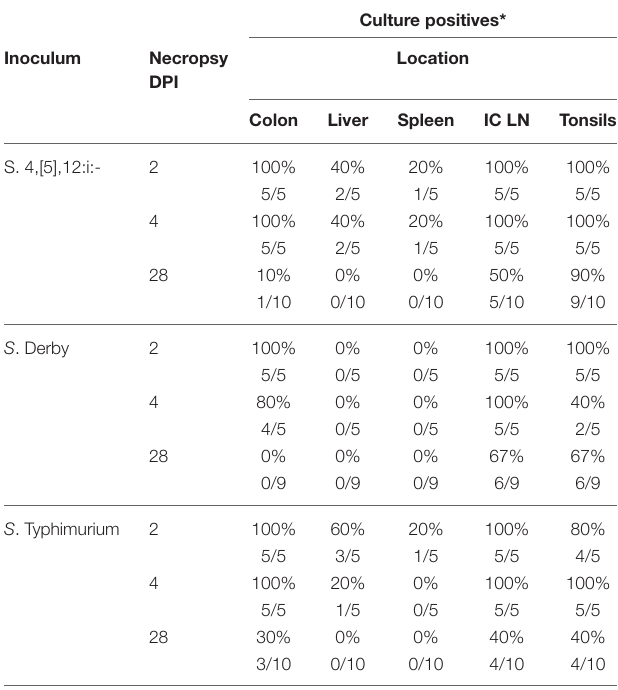
FIGURE 6 | Comparison of quantitative culture results for Salmonella in feces collected from pigs inoculated with Salmonella serovars 4,[5],12:i:-, Typhimurium, and Derby in animal study #2. The mean CFU/mL and standard error are represented by the horizontal and vertical lines, respectively. Statistically significant differences ( p < 0.05) were determined within each group compared to DPI 0 at which time no Salmonella was detectable. Days with significant differences present from DPI 0 are represented by asterisks and were as follows: S. 4,[5],12:i:- on DPI 2, 4, and 7; S. Derby on DPI 2, 4, and 7; S. Typhimurium on DPI 2, 4, 7, and 14. TABLE 3 | Comparison of Salmonella culture results from samples collected during necropsy from pigs inoculated with Salmonella serovars 4,[5],12:i:-, Typhimurium and Derby in animal study #2.